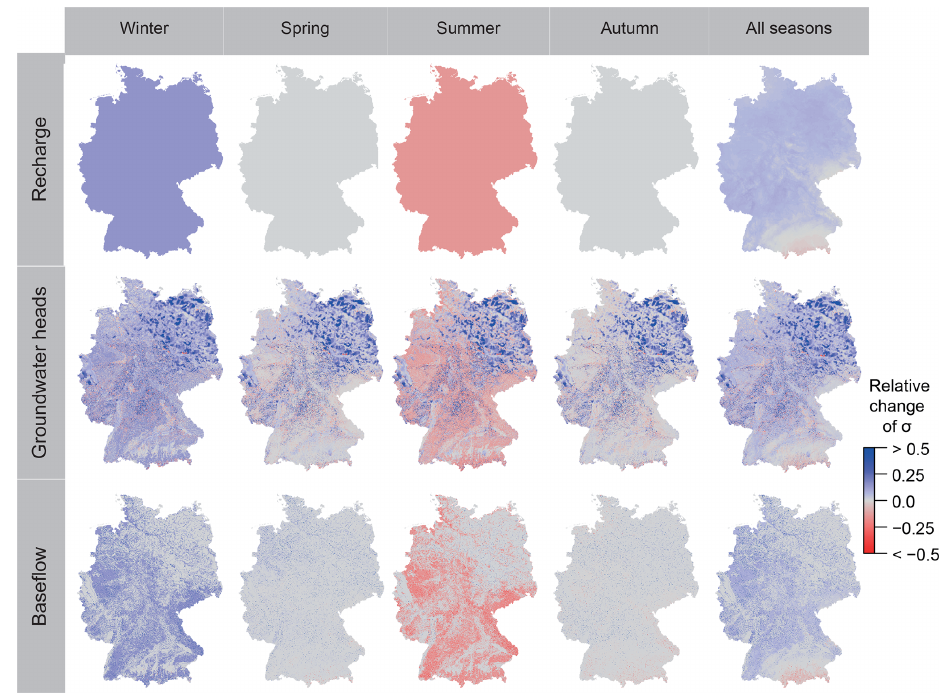
Figure 4. Relative changes in the inter-annual variability of recharge, groundwater head and baseflow for different seasons (with winter: DJF, spring: MAM, summer: JJA, autumn: SON) and a seasonal shift of